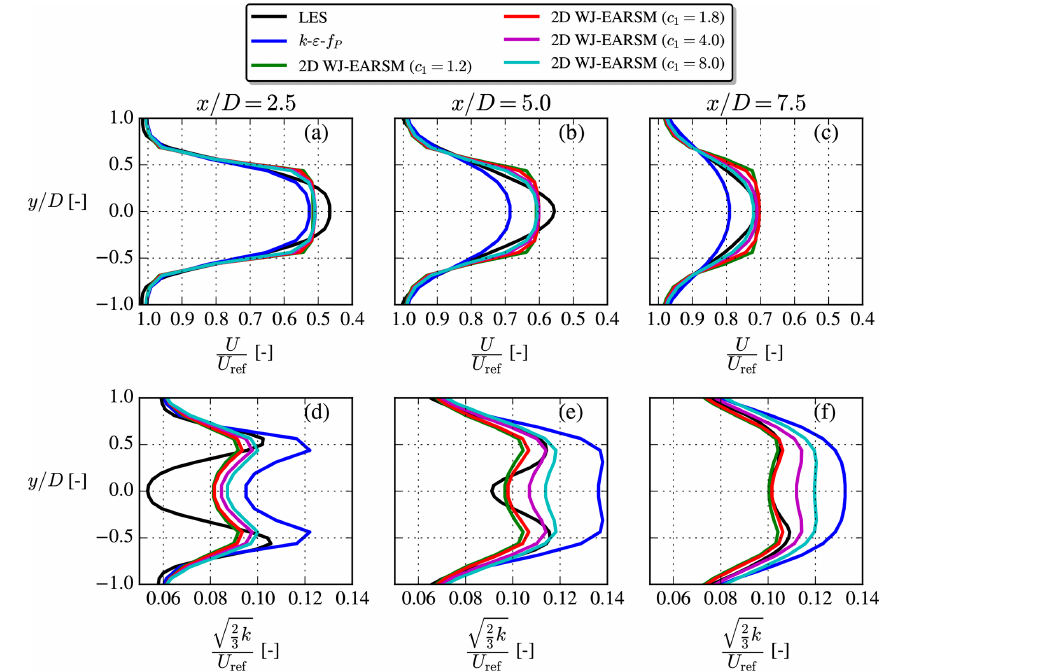
Figure B2. Streamwise velocity (a–c) and TI (d–f) profiles extracted at various downstream positions for the single-wake V80 case with different sets of model constants.